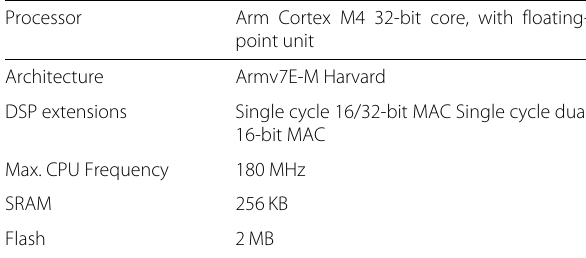
Table 4 FRDM K66F key specs